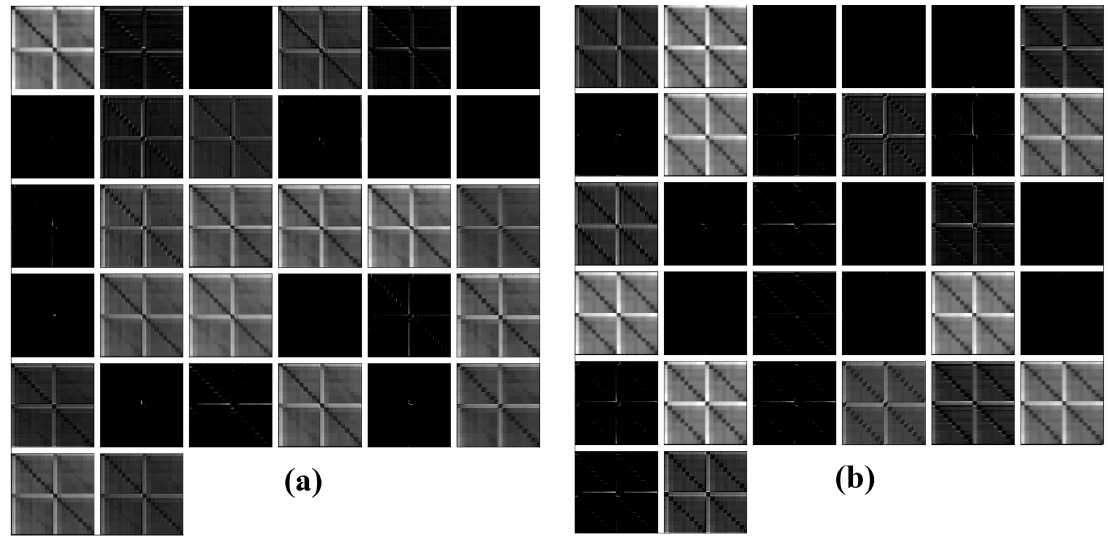
Figure 12. Feature maps for the 1st CNN layer after applying 32 kernels into PZT#2 frames for the structural conditions: ( a ) D1; ( b ) H.